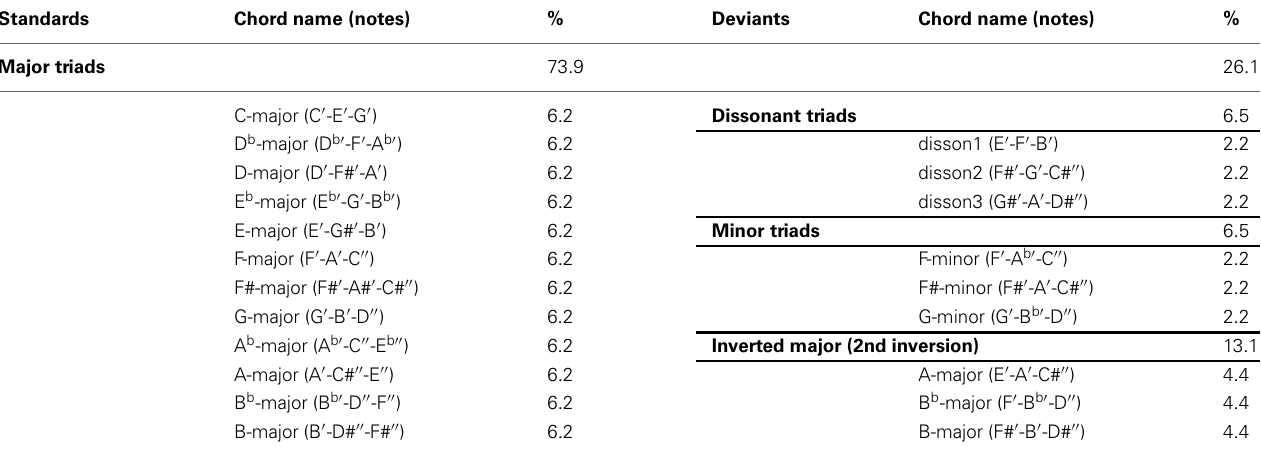
Table 2 | The experimental stimuli (chords) and their note structure.